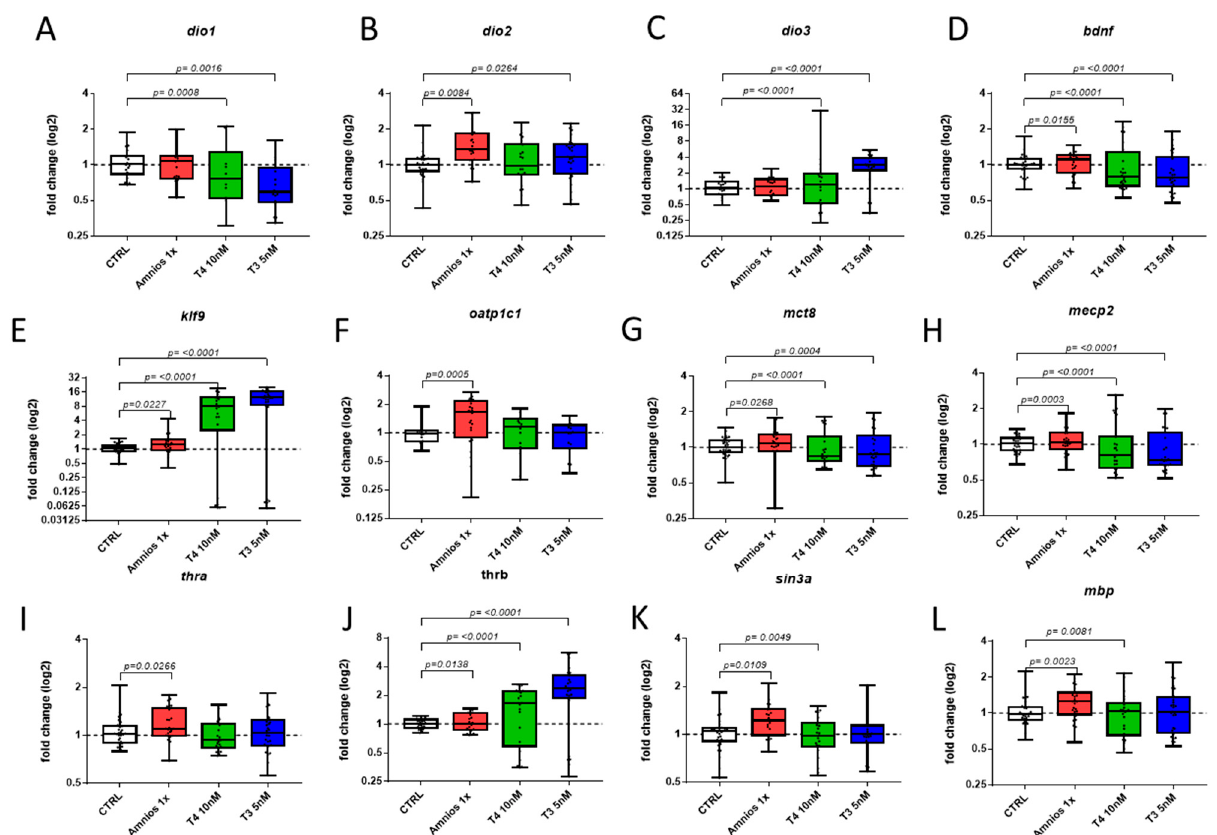
Figure 2. Gene expression after embryonic exposure to the amniotic mixture and THs. Embryos (NF 1–NF 47) were exposed to DMSO (CTRL), amniotic mixture at 1x concentration (Amnios 1X), T 4 (10 nanomolar), and T 3 (5 nanomolar). After brain dissection at stage NF 47, RNA extraction and RT-qPCR were conducted on genes involved in the TH signaling pathway, ( A ) dio1 , ( B ) dio2 , ( C ) dio3 , ( E ) klf9 , ( F ) oatp1c1 , ( G ) mct8 , ( I ) thra , ( J ) thrb , and brain development, ( D ) bdnf , ( H ) mecp2 , ( K ) sin3a , and ( L ) mbp . Results are normalized to the geometric mean of the expression levels of the genes ube2m and ralb . Results are a pool of 6 independent replicates with n = 5 by group by replicate. The line in each box represents the median.